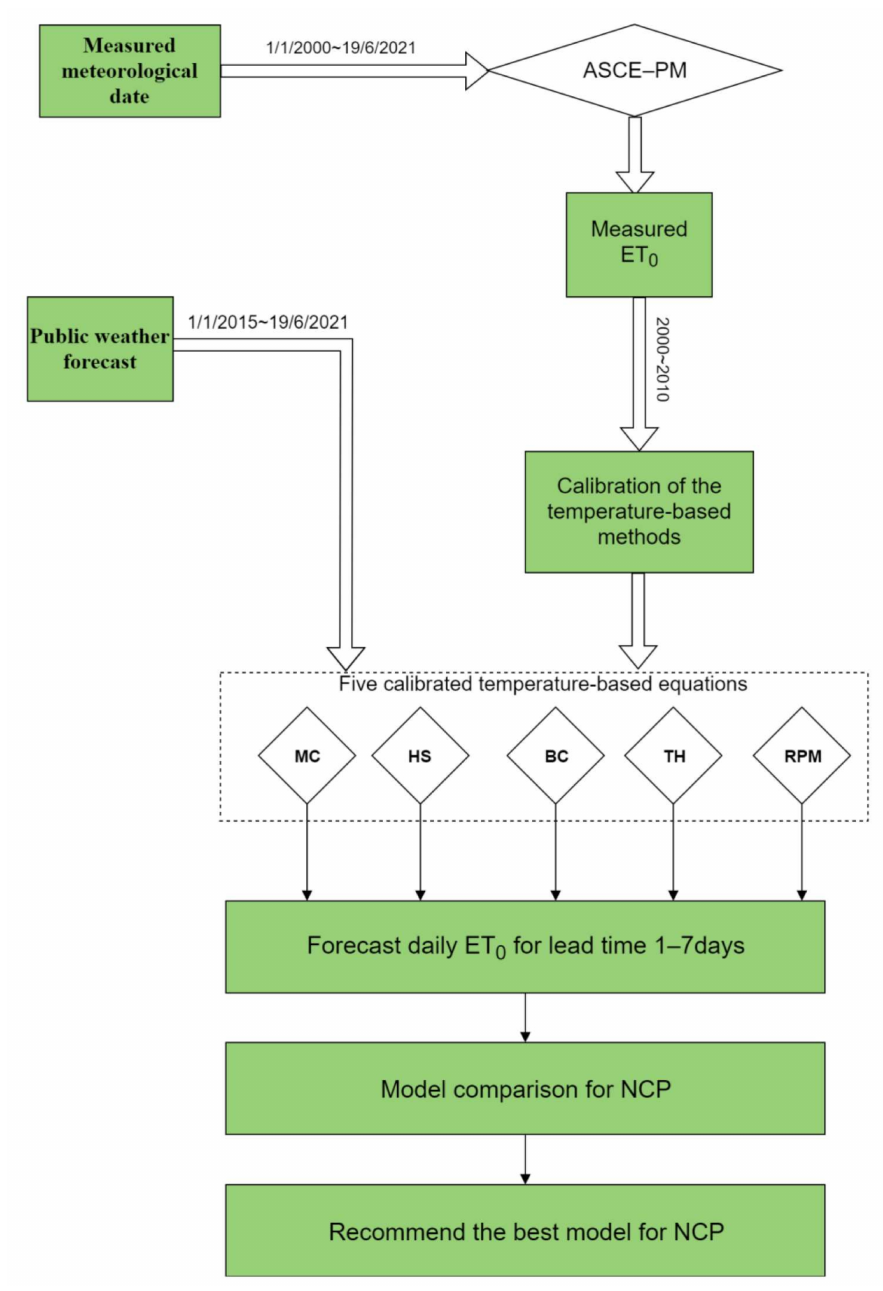
Figure 2. Workflow of the ET 0 forecasting in this